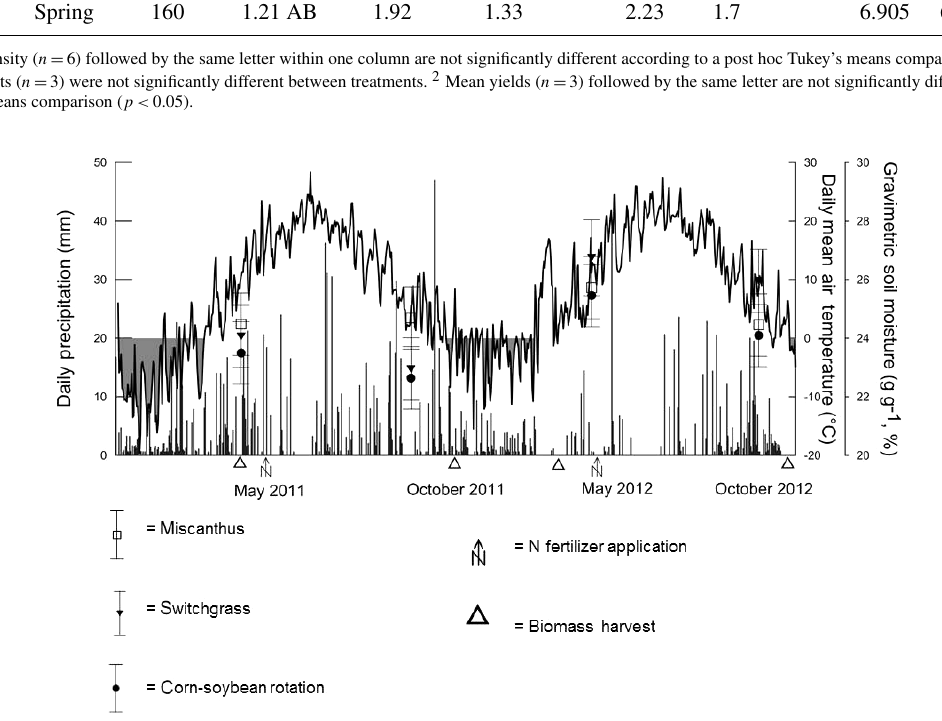
Figure 1. Mean daily air temperature ( ◦ C) and daily precipitation (mm) at the Elora Research Station from January 2011 to November 2012. Soil gravimetric H 2 O was measured on a per-sample basis and is shown as crop means ( ± SE) for each sampling date (9 May 2011, 30 October 2011, 2 May 2012, and 20 October 2012) ( n = 12 in perennial grasses, n = 6 in corn–soybean